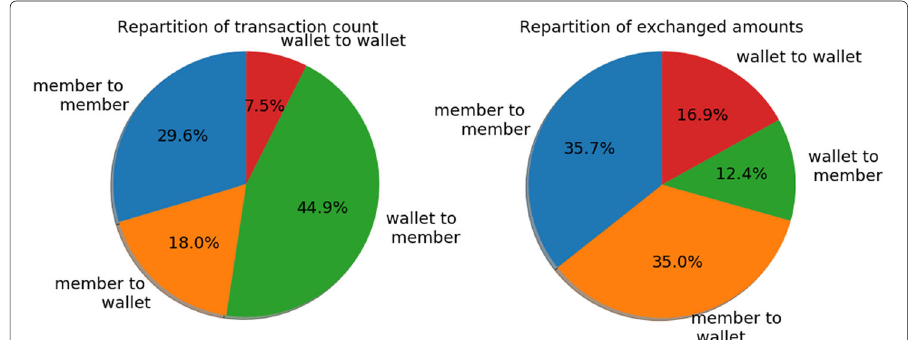
Fig. 3 The transaction stream T can be divided in four substreams: transactions between member accounts T T T MM , between member and anonymous accounts MA , between anonymous and member accounts AM , and between anonymous accounts T AA . Left - Repartition of the transactions between the different transaction substreams. Right - Repartition of the exchanged amounts between the different transaction substreams. Notice that, although T AM represents about 45% of T in terms of number of transactions, it only adds up to 12.4% of the exchanged volume